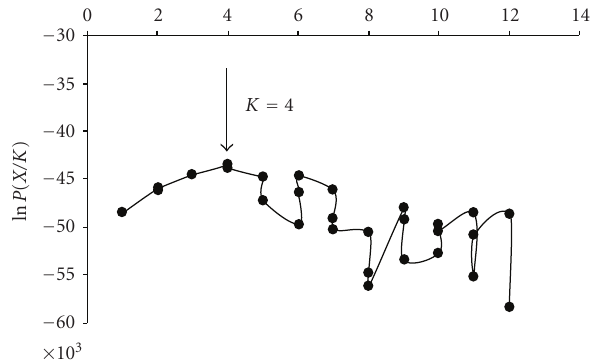
Figure 2: Estimated posterior probability of the number of cluster K for Milicia excelsa populations, with STRUCTURE program.